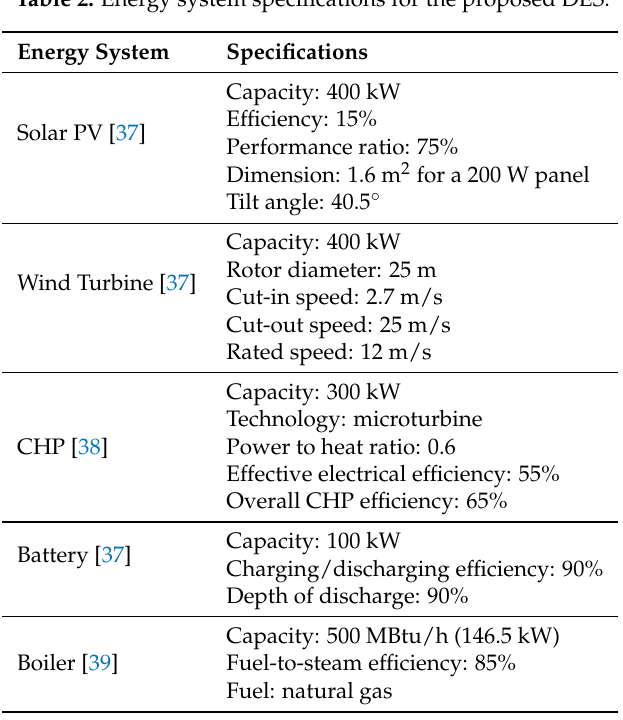
Figure 5. Diagram of the proposed district energy system management. Table 2. Energy system specifications for the proposed